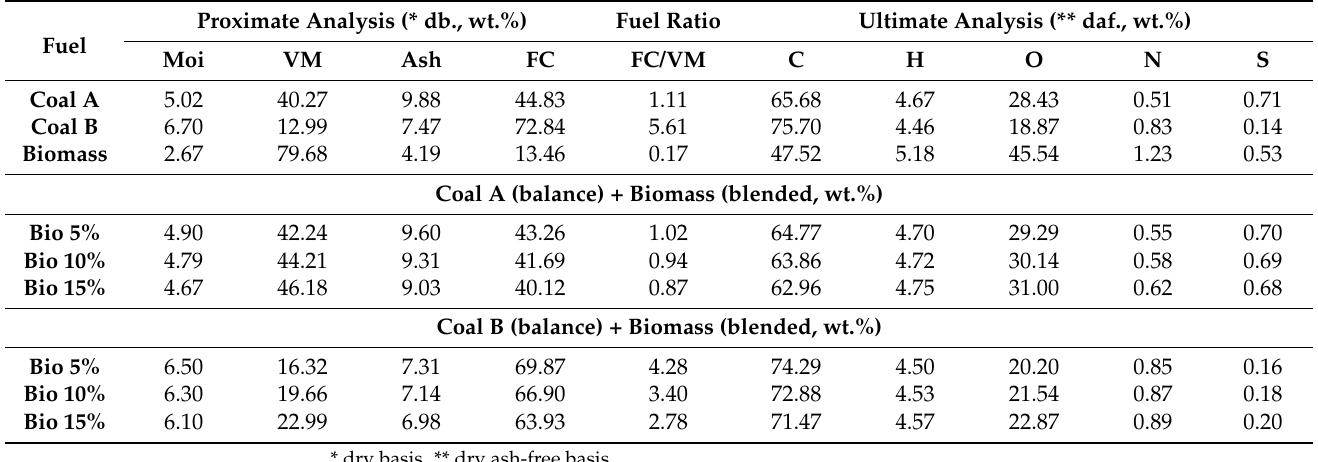
Table 1. Proximate and ultimate analysis results of the samples.